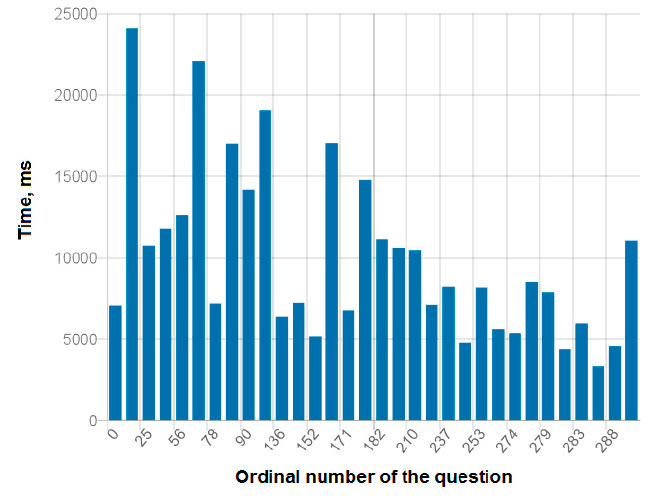
Figure 2. Reaction time to the questions.